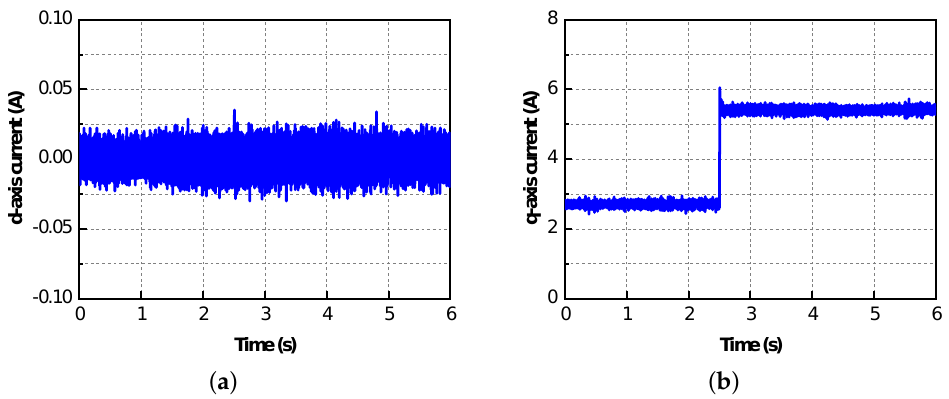
Figure 16. Simulation results of current using the inductance matrix table. ( a ) d-axis current and ( b ) q-axis